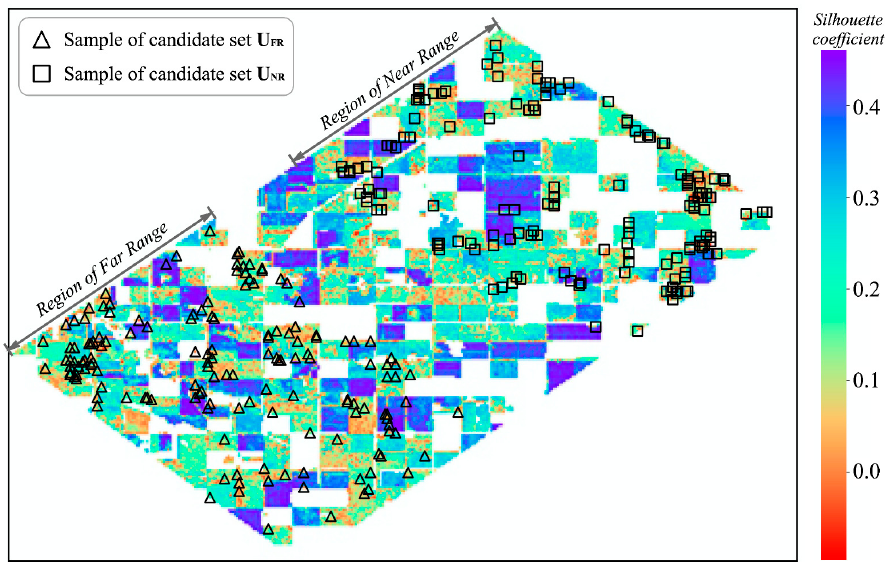
Figure 5. Visualization of the distribution of the candidate sample sets. The background image is the heatmap of the samples’ silhouette coefficients.